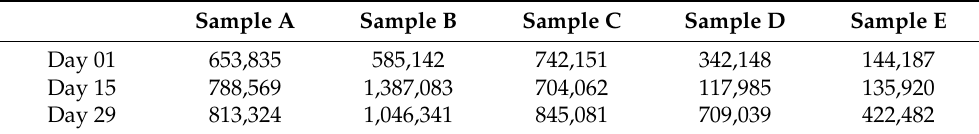
Table 2. Total number of segmented RBCs.